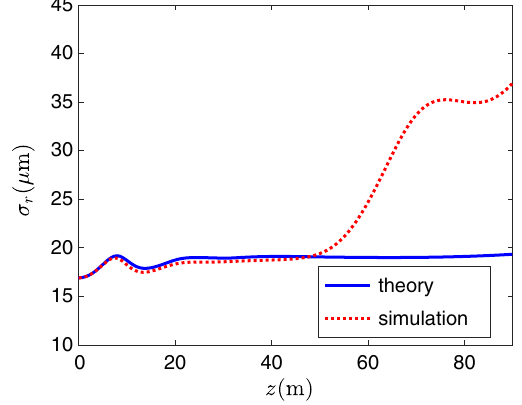
FIG. 2. Radiation beam size versus z for a kick angle of 1 . 54 μ rad (theory and GENESIS simulation results).